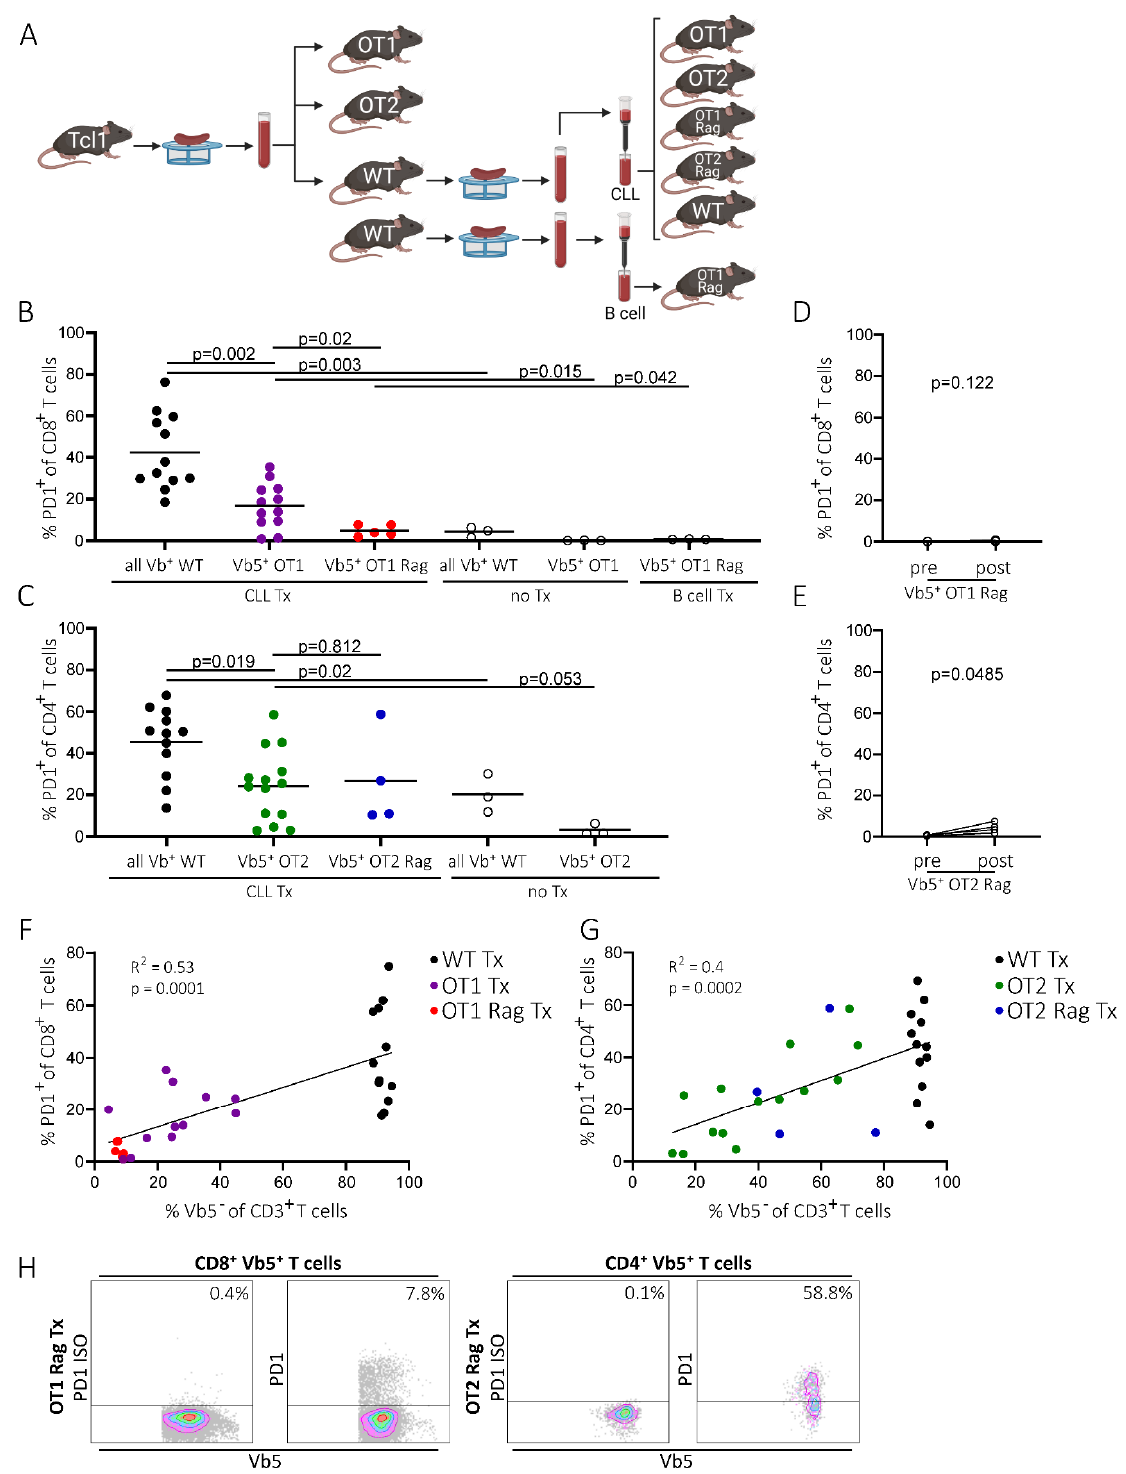
Figure 3. PD1 expression of T cells in OT1 Rag and OT2 Rag mice. ( A ) Transplantation scheme of OT1/OT2, OT1 Rag/OT2 Rag, and WT mice. Spleens derived from transplanted or non-transplanted WT mice were homogenized and T cells were depleted via a pan-B/CLL cell MACS isolation in order to inject CLL or healthy B cells without large amounts of endogenous T cells (created with BioRender.com, 11th June 2021). ( B ) Flow cytometry data of splenic PD1pos CD8pos T cells of WT (all Vbpos), OT1 (Vb5pos), and OT1 Rag (Vb5pos) mice either transplanted with CLL cells (CLL Tx), B cells (B cells Tx), or non-transplanted (no Tx). Bars represent mean. ( C ) Splenic CD4pos PD1pos T cells from either CLL-transplanted (CLL